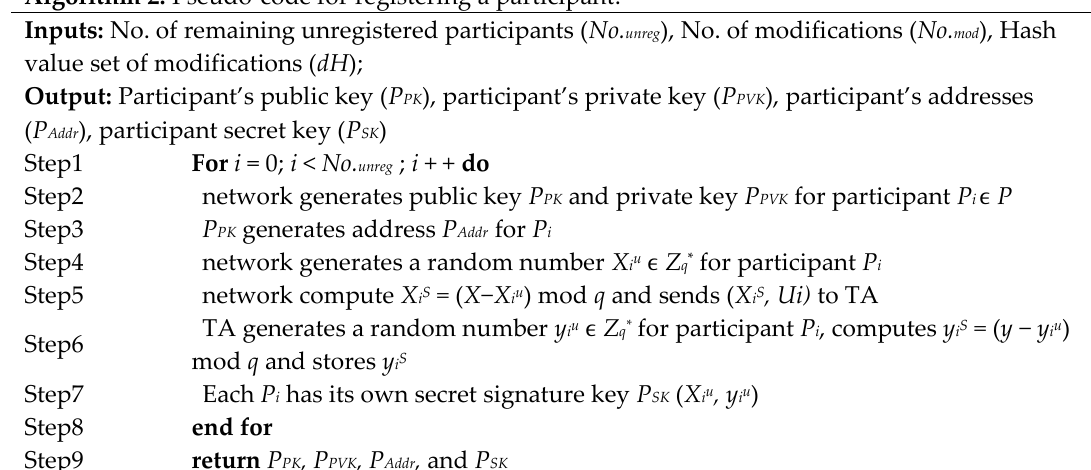
Algorithm 2. Pseudo-code for registering a